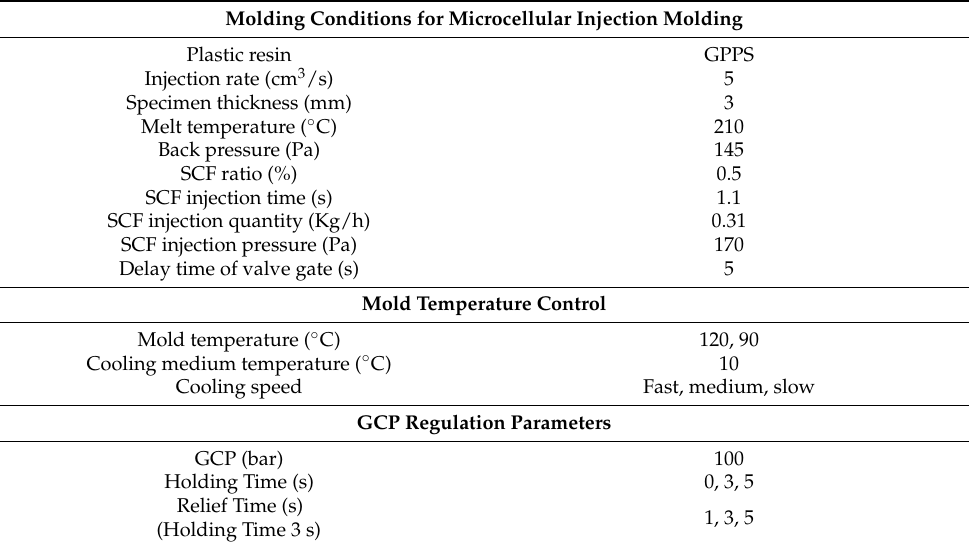
Figure 5. The typical measured pressure and temperature profiles. Table 1. Molding conditions for microcellular molded part quality experiment using P-T path.